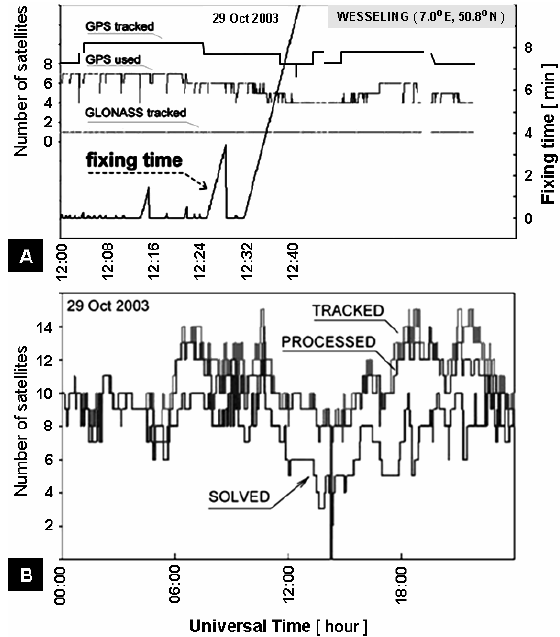
Fig. 1. A : Time required to fix ambiguities: a case during the iono- spheric storm on 29 October 2003. Notice the increased fixing time (more than 3min) at 12:24 UT and the breakdown at 12:32 UT. B : Storm effects demonstrated on the number of tracked, processed, and solved satellites. Normally, the number of processed satellites should be equal to the number of solved